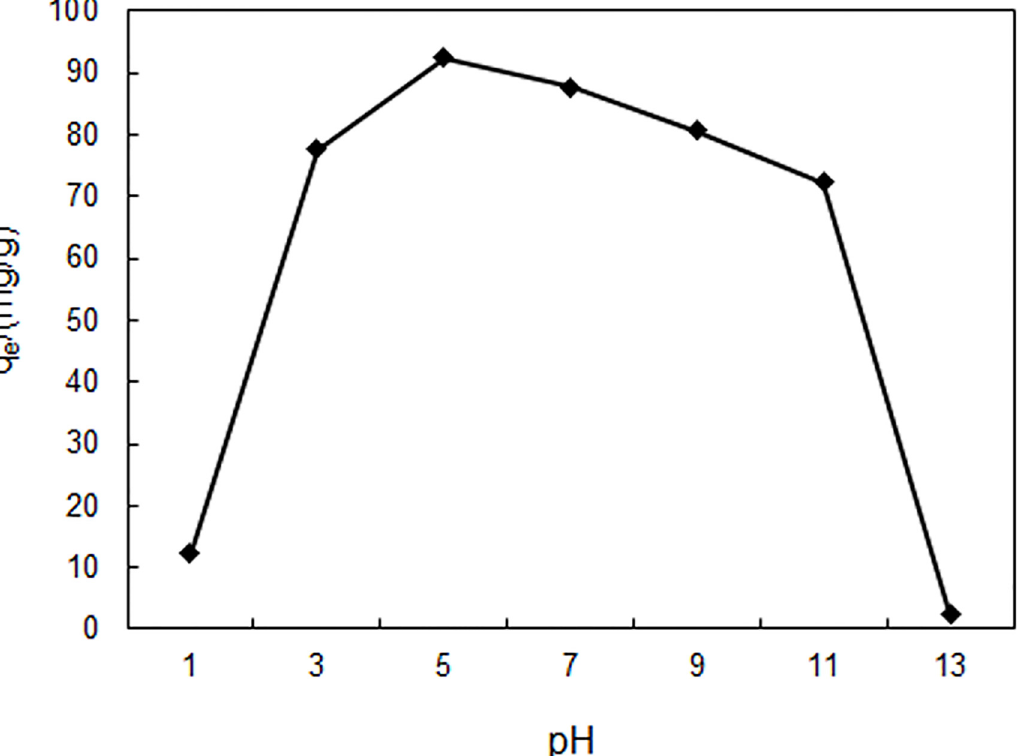
Fig 3. The effect of pH on equilibrium absorption capacity. (experimental conditions: c 0 = 100 mg/L, T = 303 K, contact time = 90min and absorbent dosage = 0.10g).